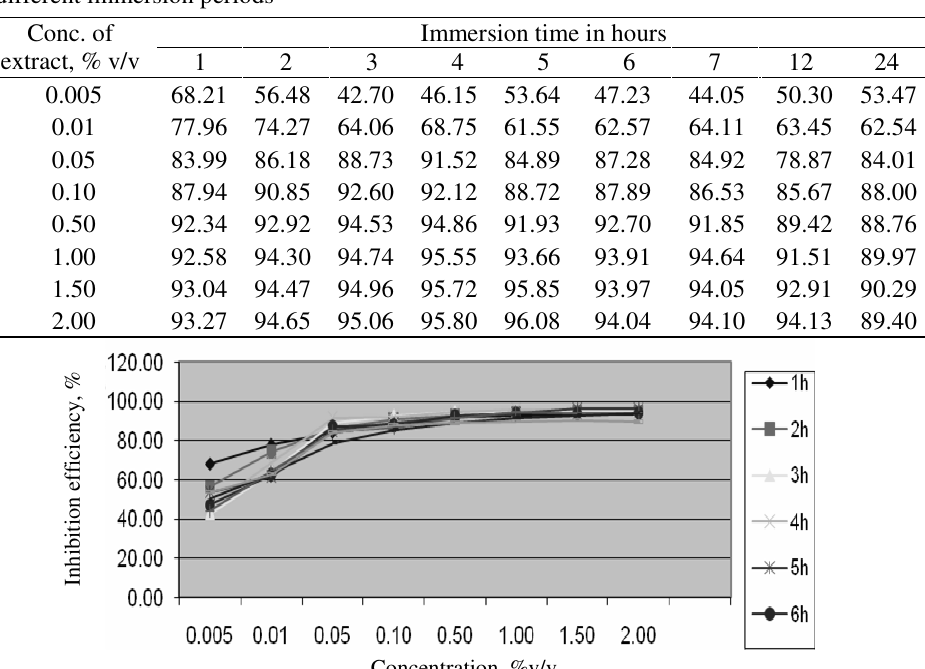
Table 1. IE % of MNP extract on mild steel in 1 N HCl at different concentration and